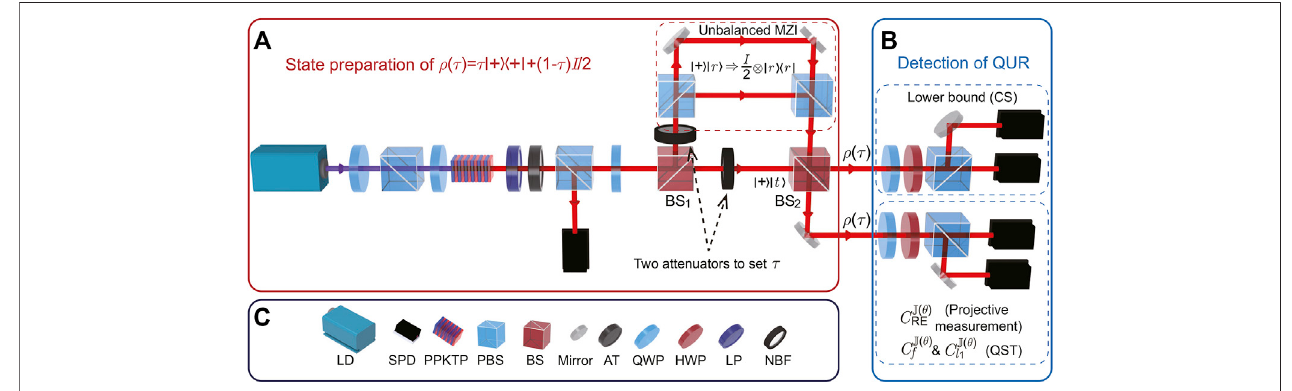
FIGURE 1 | Schematic illustration of the experimental setup. (A) The setup to generate the family of states ρ ( τ ) (cid:2) τ | + 〉〈 + | + ( 1 − τ ) I implement the measurements with CS algorithm and QST. (C) Symbols used in (A) and (B) . Laser diode (LD); single-photon detector (SPD); attenuator (AT); long-wave pass fi lter (LP); narrow-band fi lter (NBF).